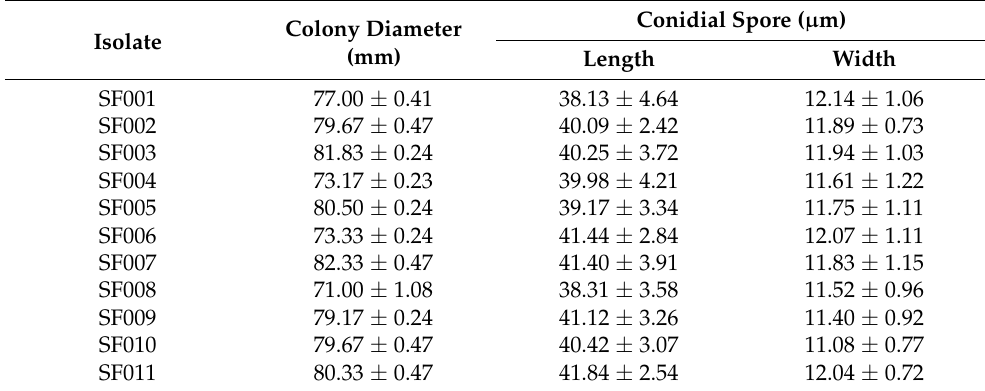
Figure 3. Colonies and conidia of the pathogen causing sugarcane leaf blight. On the upper is the pathogen growing on PDA in the dark for 9 days, on the lower side are pathogen and conidia grown on CMA for 14 days after 24 h NUV light induction. ( a ). Upper sides of a PDA plate; ( b ). reverse sides of a PDA plate; ( c ). upper sides of a CMA plate; ( d ). reverse sides of a CMA plate; ( e ). conidia of isolate. Bars: 20 µ m. Table 2. Morphological descriptions of the pathogens causing sugarcane leaf blight investigated in this